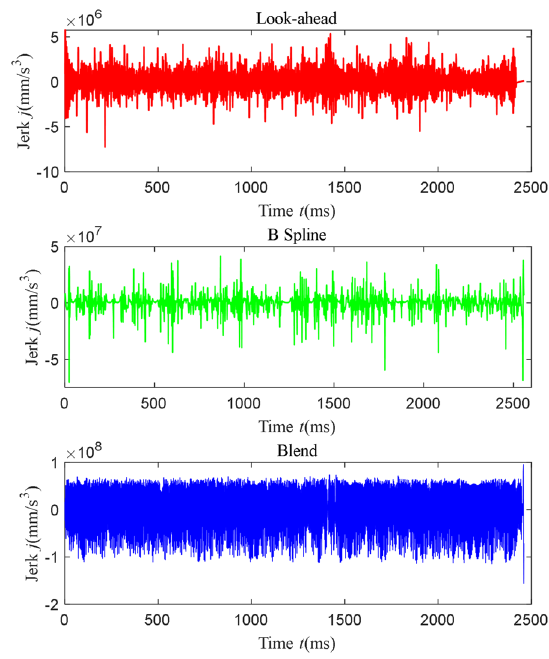
Figure 12 Comparison of velocity values using the three methods